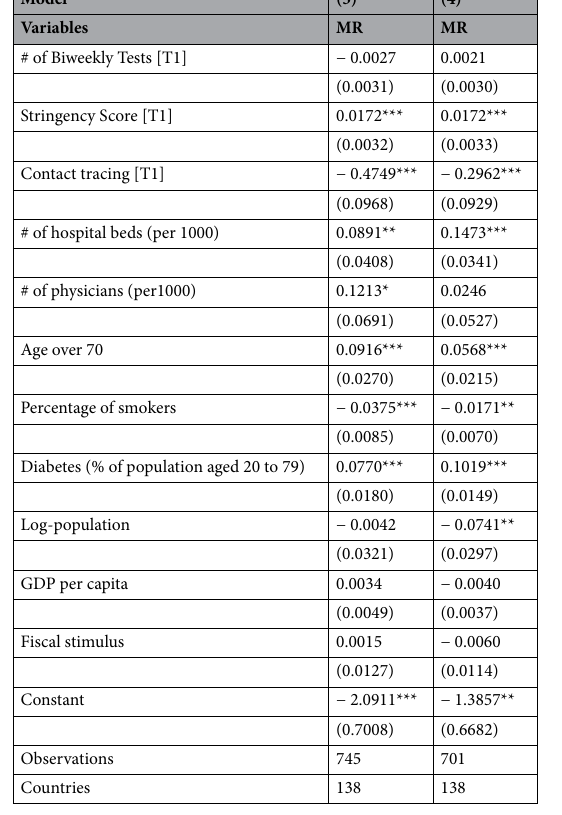
Table 3. Longitudinal data regression models for mortality rates on time 2 [T2]. Robust standard errors in parentheses. We estimate Model 3 including outliers. Model 4 excludes outliers. ***p < 0.01, **p < 0.05, *p <